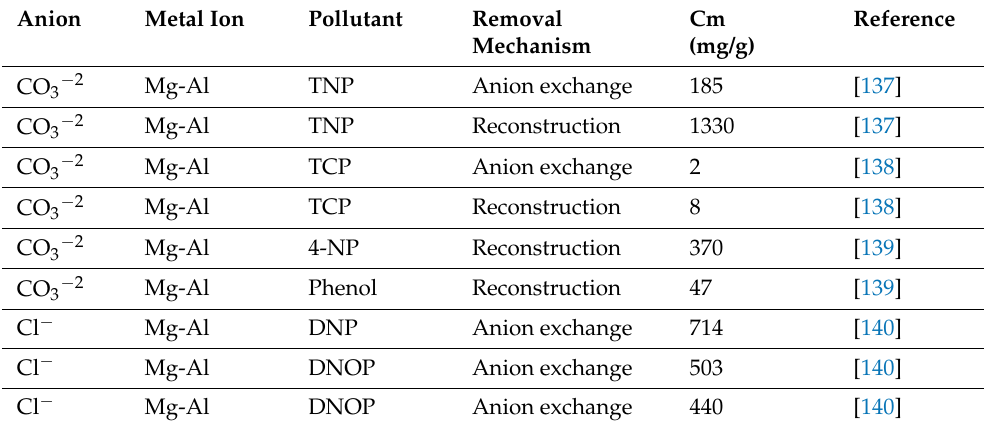
Table 3. LDH materials: proposed mechanism and maximum removal capacity (Cm) proposed by different research